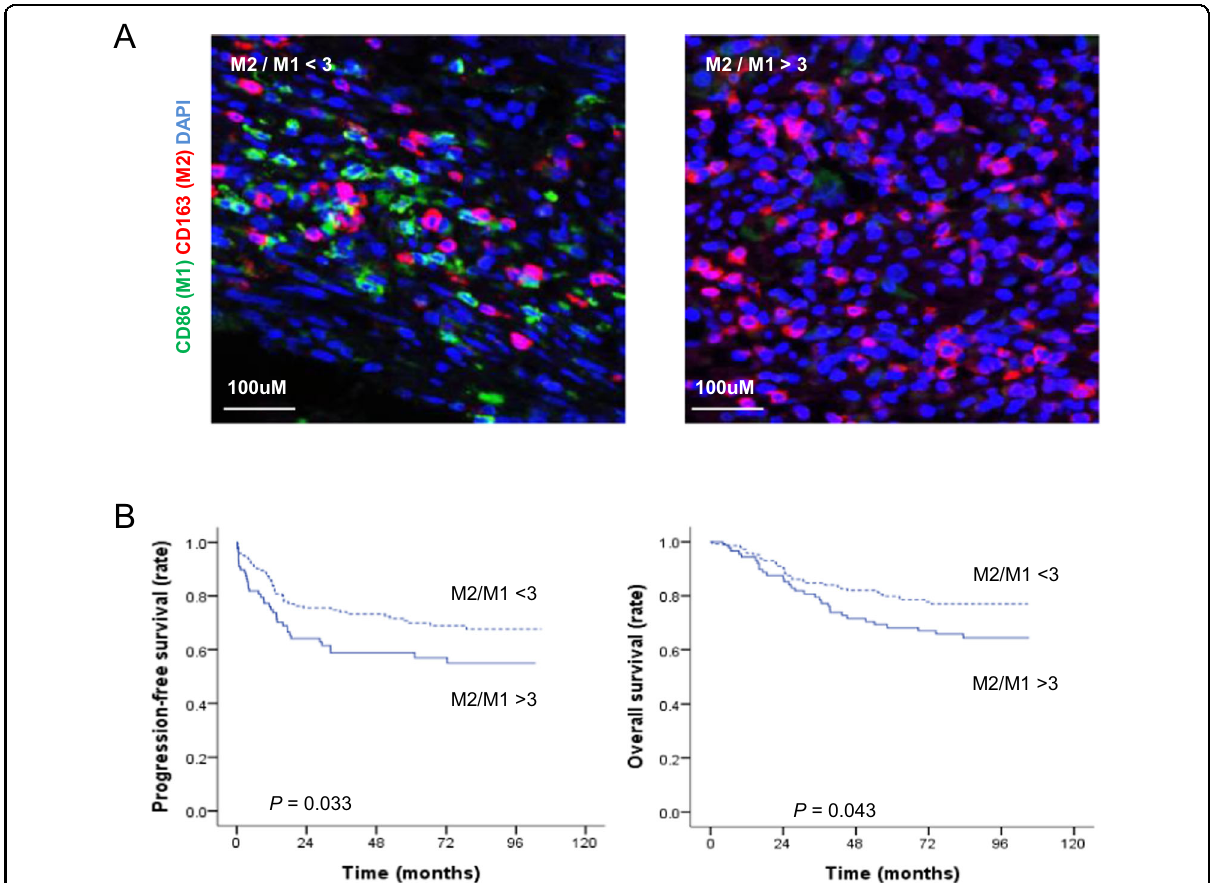
Fig. 8 Survival analysis according to the M2 marker (CD163) to M1 marker (CD86) ratio in the validation cohort. a Representative immunohistochemical staining for markers of M1 macrophages (CD86, green) and M2 macrophages (CD163, red) in CRC tissues. Dried slides were scanned using the PerkinElmer Vectra 3.0 platform at ×20 magni fi cation. Nuclei were shown by DAPI staining (blue). Scale bar: 100 µm. b Kaplan – Meier curves for progression-free survival (left panel) and overall survival (right panel) of the two groups were divided by an optimal cutoff value of 3 for the ratio of M2 marker (CD163) to M1 marker (CD86). Statistical analysis by long-rank test: p = 0.033 and p = 0.043,